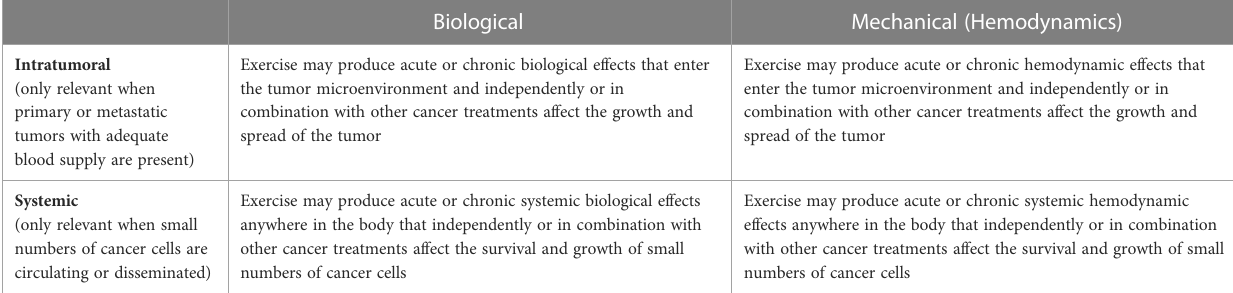
TABLE 5 General categories of mechanisms for explaining how exercise may affect cancer-speci fi c outcomes. Biological